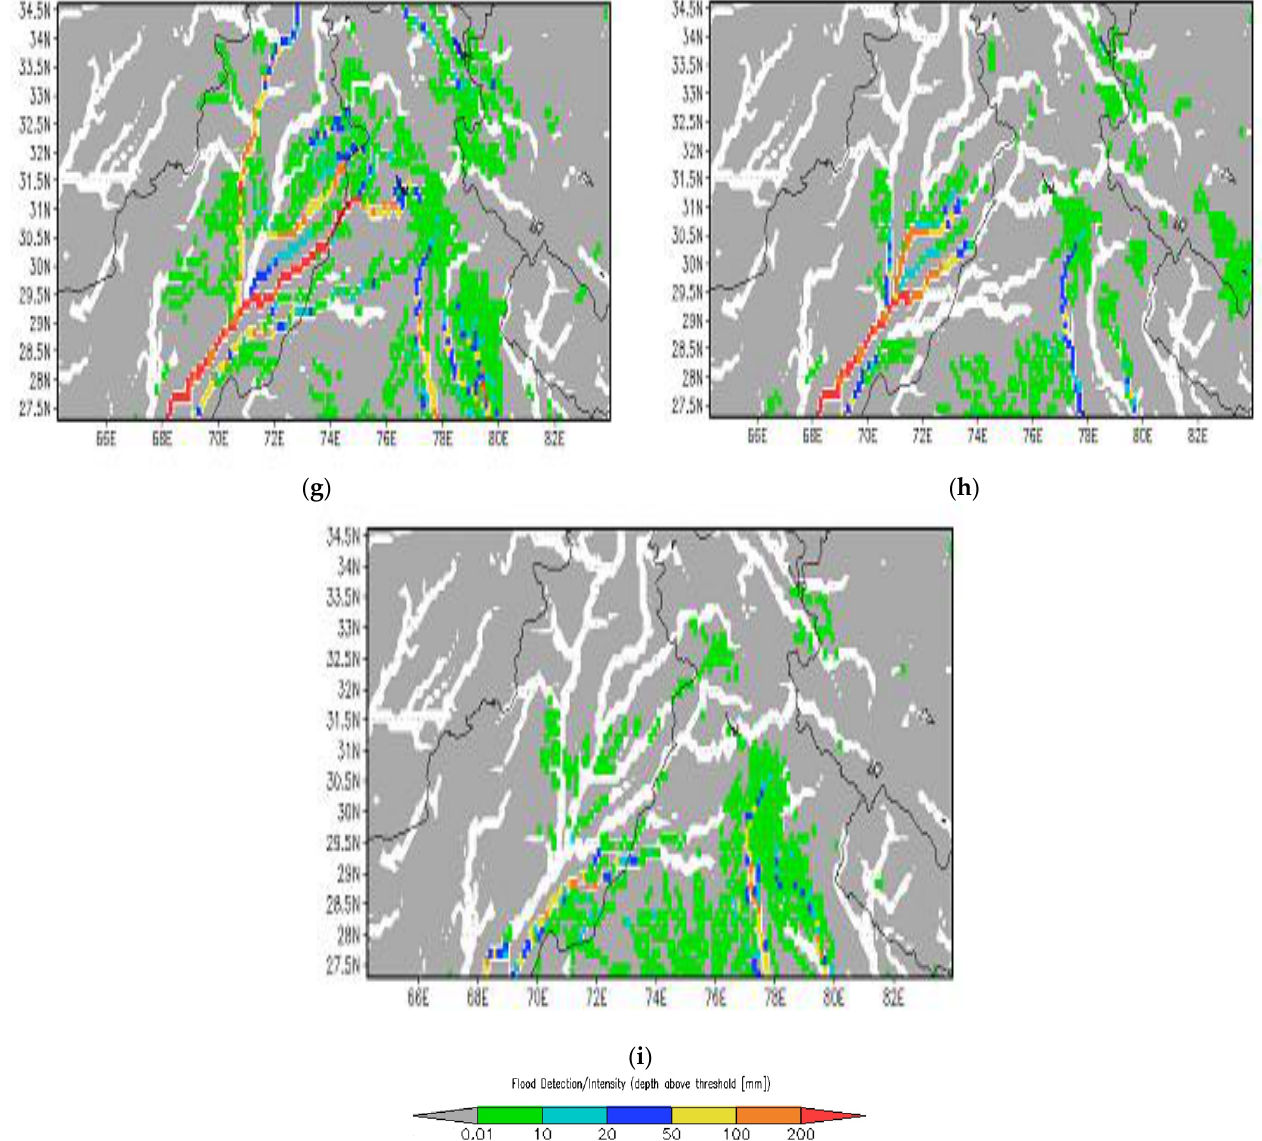
Figure 9. Flood detection/intensity above the flood threshold from 21Z20July2010 to 21Z06Sep2010 with water depth in (mm) at 1 km pixel area resolution. This depicts the maximum flood intensity above the threshold in the region and the normal conditions for winter season during 2010. ( b – i ) show the flood streamflow events that occurred on 20 July, 29 July, 2 August, 9 August, 13 August, 26 August, 31 August and 8 October, 2010, respectively, and ( a ) presents the flood detection/intensity and legends of intensity over the entire country.